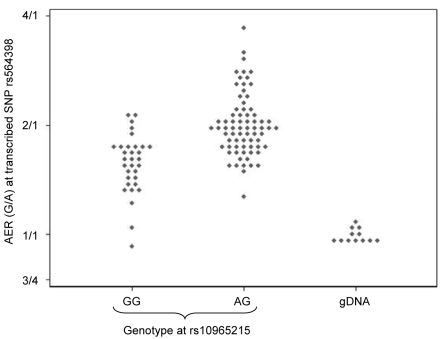
Effect of genotype at rs10965215 on allelic expression ratio of transcribed ANRIL SNP rs564398.Diamonds represent the allelic expression ratio for each individual, all of whom are heterozygous for the transcribed SNP rs564398. The first column shows individuals who are homozygous for rs10965215 (mean ratio 1.57), and the second column shows individuals who are heterozygous for rs10965215 (mean ratio 2.00). The third column shows the expression ratio obtained from genomic DNA in individuals who are heterozygous for the transcribed SNP rs564398, where the two alleles are present in a 1∶1 ratio (mean ratio 1.00).